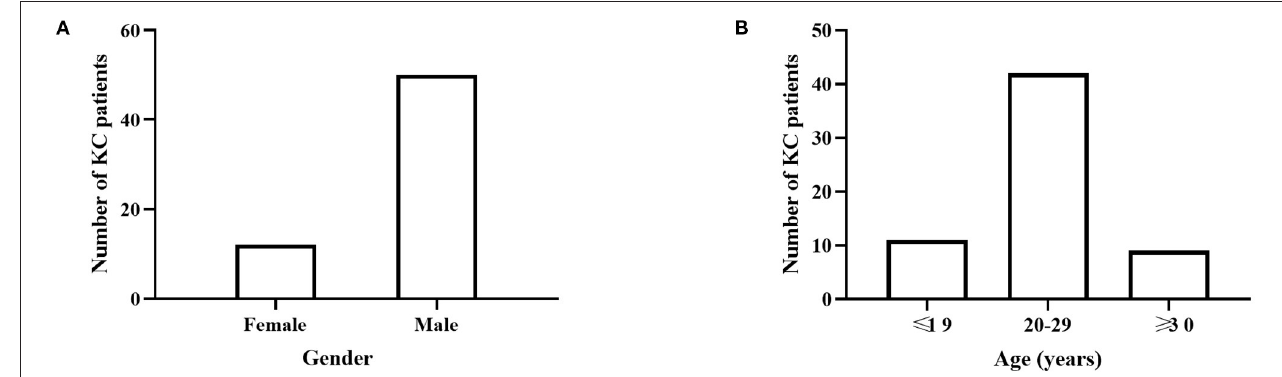
FIGURE 1 | The disease distribution in different gender and age groups. (A) There were more males (50; 80.65%) in KC cases. (B) KC patients’ ages were concentrated between 20 and 30 years.